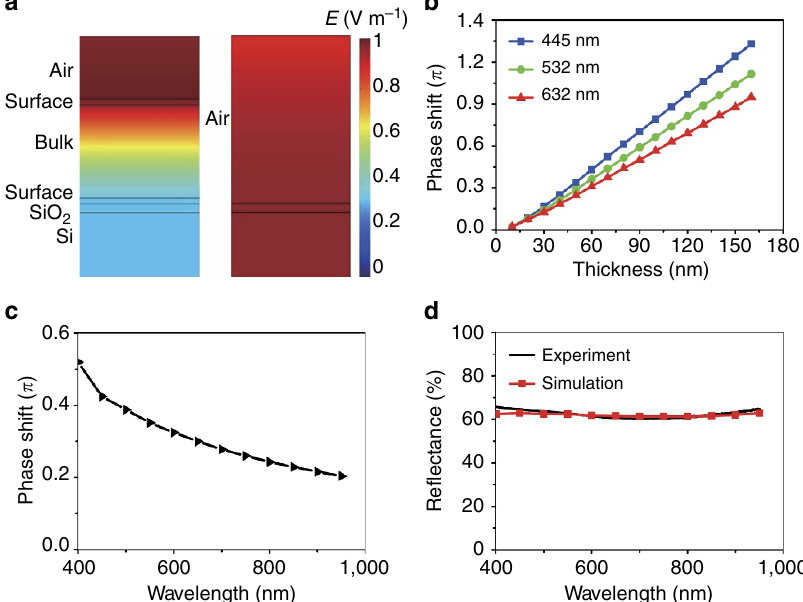
Figure 3 | Numerical simulations of electromagnetic fields and phase shift. ( a ) Simulated electromagnetic field distributions in the Sb 2 Te 3 thin film cavity and the SiO 2 /Si substrate under illumination with 632nm light. ( b ) Simulated phase shift between the Sb 2 Te 3 film and the SiO 2 /Si substrate as a function of the film thickness at different wavelengths. ( c ) Simulated phase shift between the 60nm Sb 2 Te 3 film and the SiO 2 /Si substrate as a function of wavelength. ( d ) Simulated and experimental reflectance of 60nm Sb 2 Te 3 thin films as a function of wavelength. The simulation shows good agreement with shift is B 0.5 p , 0.4 p and 0.3 p at the wavelengths 445, 532 and the wavelength increases. These results demonstrate that Sb 2 Te 3 thin films generate higher quality holographic images with 632 nm, respectively. Figure 3c shows the simulated phase shift shorter wavelengths. Figure 3d demonstrates the simulated and between the Sb 2 Te 3 thin film and SiO 2 /Si as a function of experimental reflectance of the 60 nm Sb 2 Te 3 thin film as a wavelength. It can be found that the phase shift decreases when